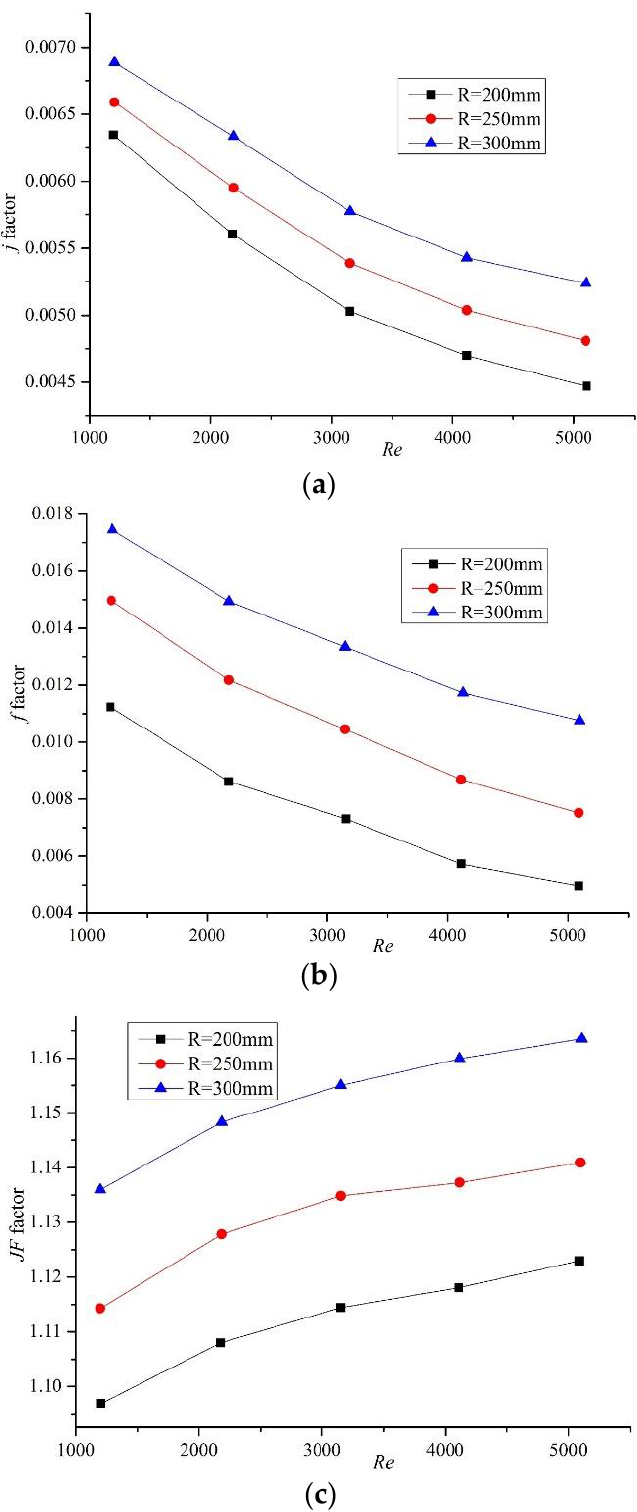
Figure 6. Performance analysis with different circular radii. ( a ) j factor; ( b ) f factor; ( c ) JF factor. As shown in Figure 6c, the JF factor is adopted as the evaluation index of the overall enhanced heat transfer performance, and the overall heat transfer performance of the circular-arc flow channel with different circular radii is analyzed. As can be seen from the figure, with the same Reynolds number, the circular-arc flow channel with a